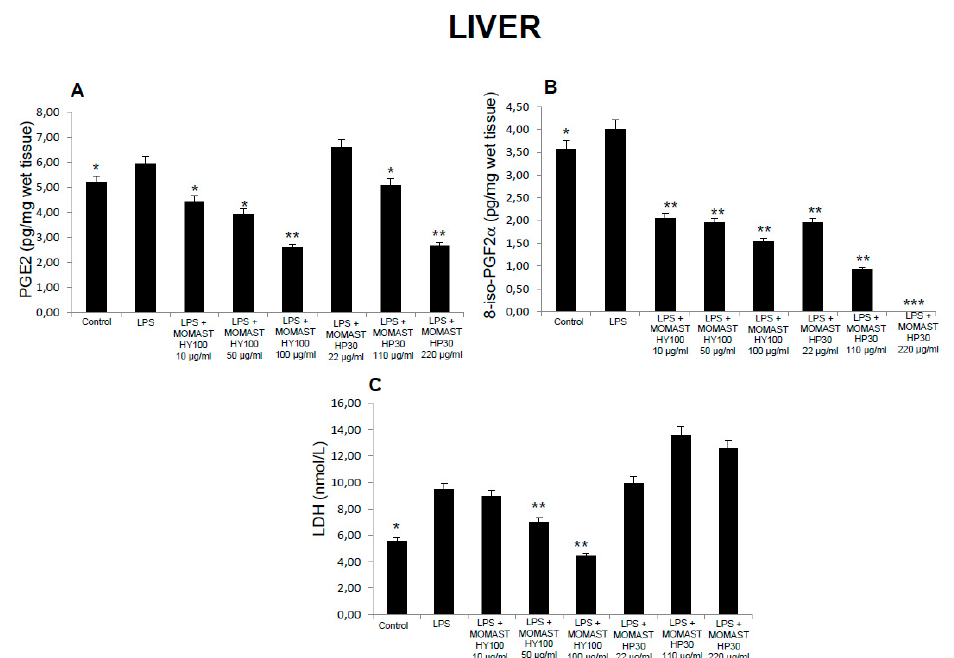
Figure 3. Effects of MOMAST( ® ) HY100 (10, 50, and 100 µg/mL) and MOMAST( ® ) HP30 (22, 110, and 220 µg/mL) on ( A ) PGE 2 levels (pg/mg wet tissue), ( B ) 8-iso-prostaglandin F 2 α (8-iso-PGF 2 α ) levels, and ( C ) lactate dehydrogenase (LDH) activity (nmol/L) in rat liver specimens. Data were reported as means ± SEM. ANOVA, p < 0.01; post-hoc test, * p < 0.05, ** p < 0.01, *** p < 0.001 vs. LPS-treated group.